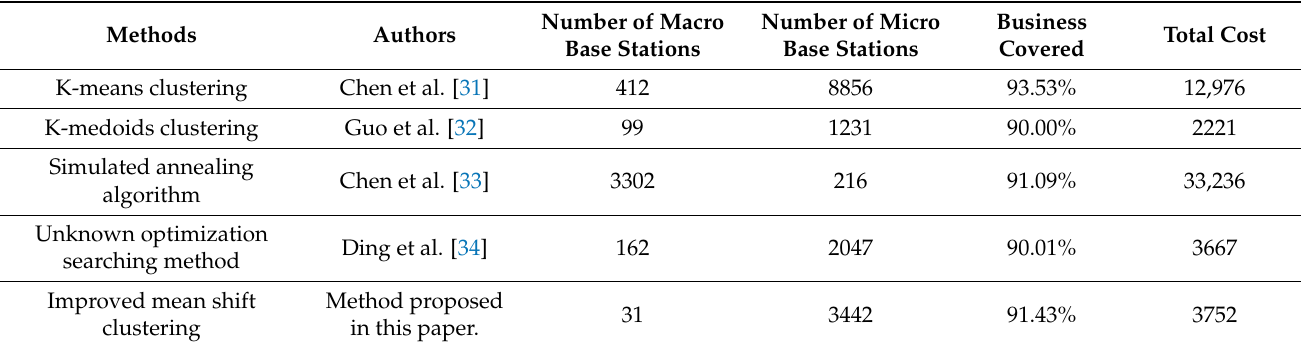
Table 6. The comparison results of different